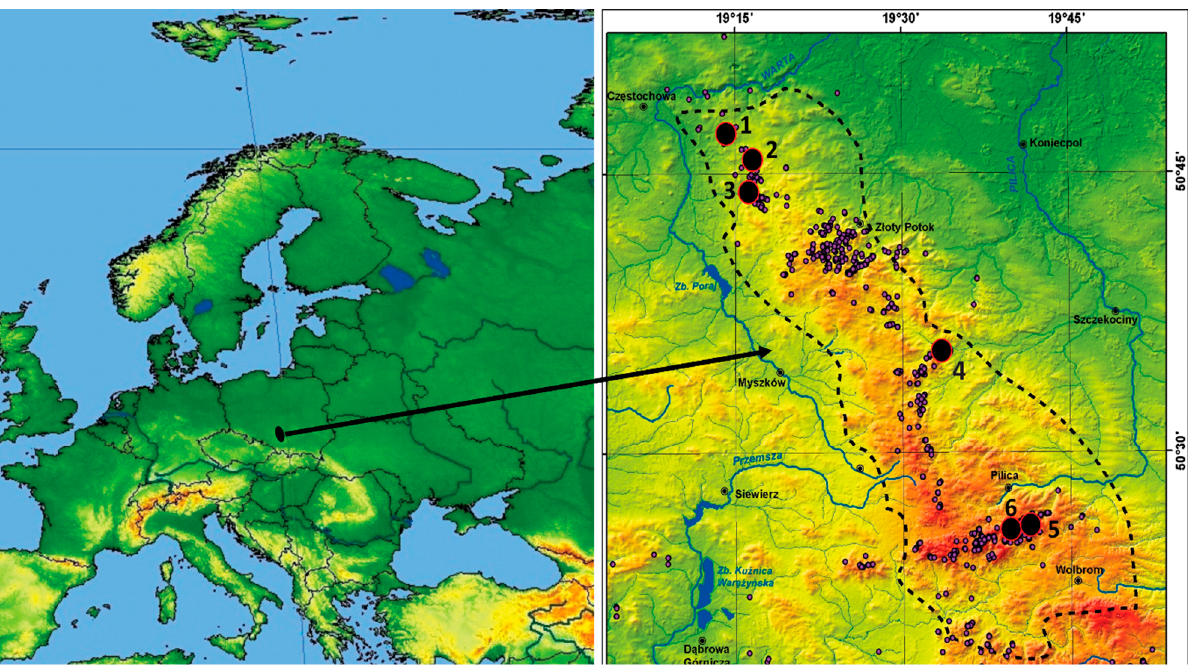
Figure 1. Location of the Cz ę stochowska Upland in Poland; studied caves marked with numbers: